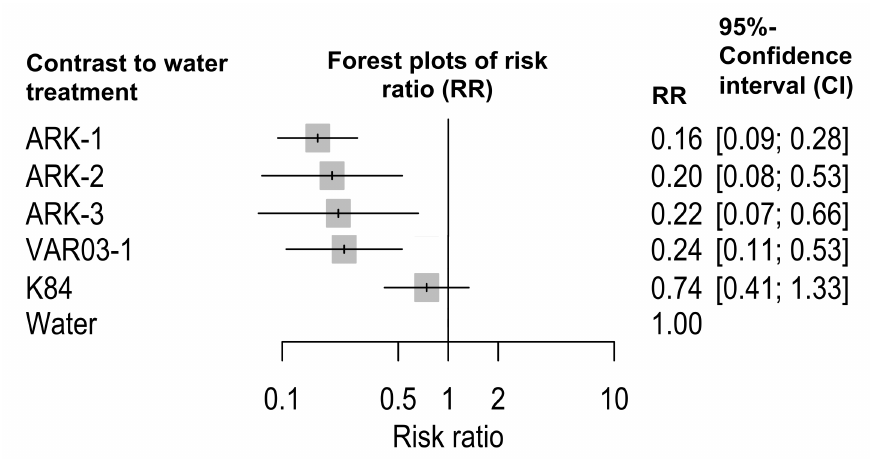
Figure 1. Evaluation based on a network meta-analysis (NMA) of the effects of the nonpathogenic Allorhizobium vitis strains ARK-1, ARK-2, ARK-3, and VAR03-1 and Rhizobium rhizogenes strain K84 on grapevine crown gall (GCG) in 16 different field experiments. In the forest plots, each gray square marks the value of the risk ratio compared with the water treatment. The spread (horizontal line) indicates the 95% confidence interval.